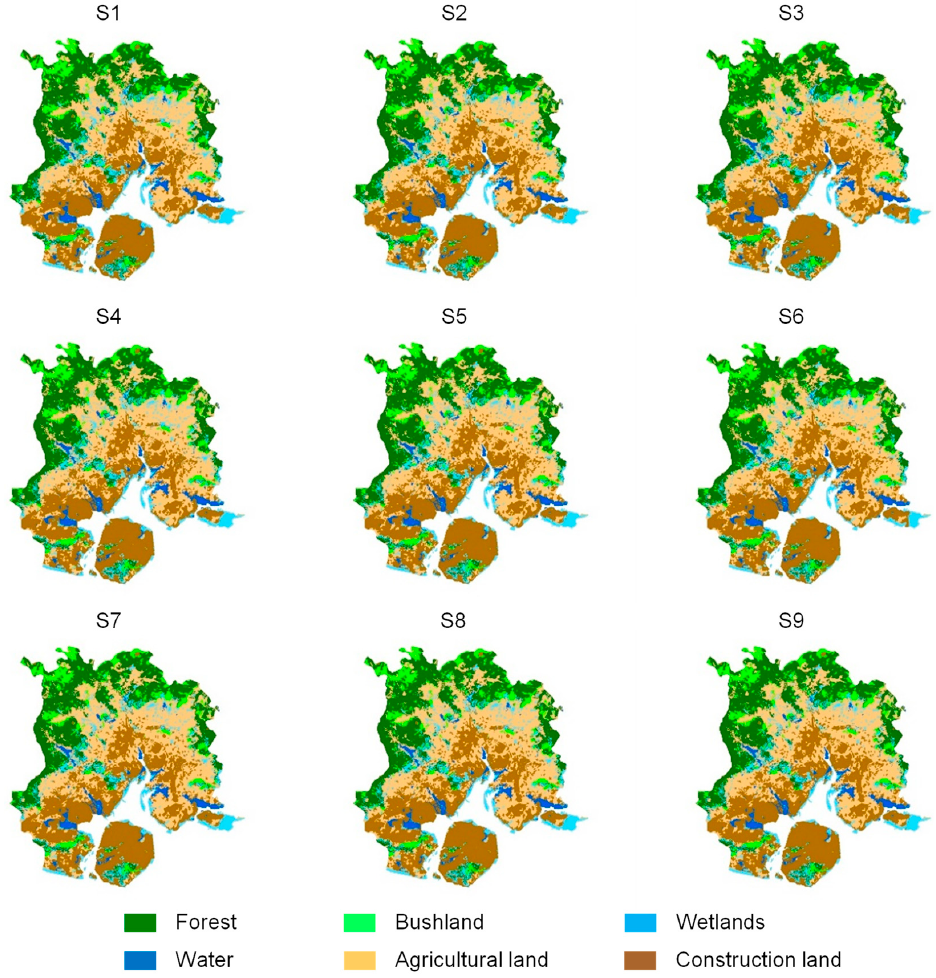
Figure 7. Spatial allocation of land resources in period 1.